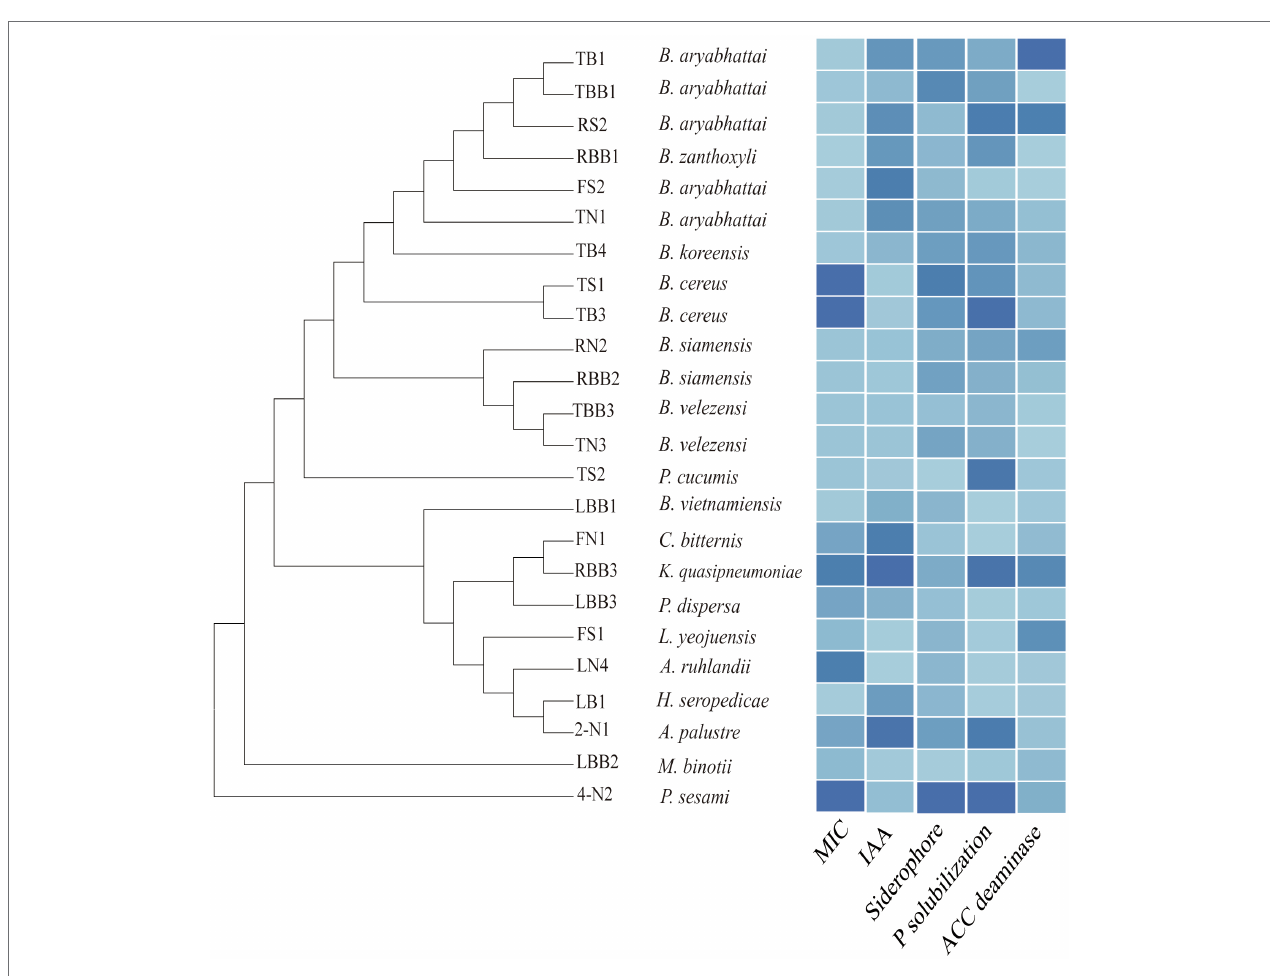
FIGURE 7 | Phylogenetic tree of the representative bacterial isolates and their minimum inhibitory concentrations (MICs) to Cd and plant growth-promoting (PGP) traits, including production of indole-3-acetic acid (IAA), siderophore, phosphate solubilization, and 1-aminocyclopropane-1-carboxylate (ACC) deaminase activities. The color gradient from dark to light represents the value from high to